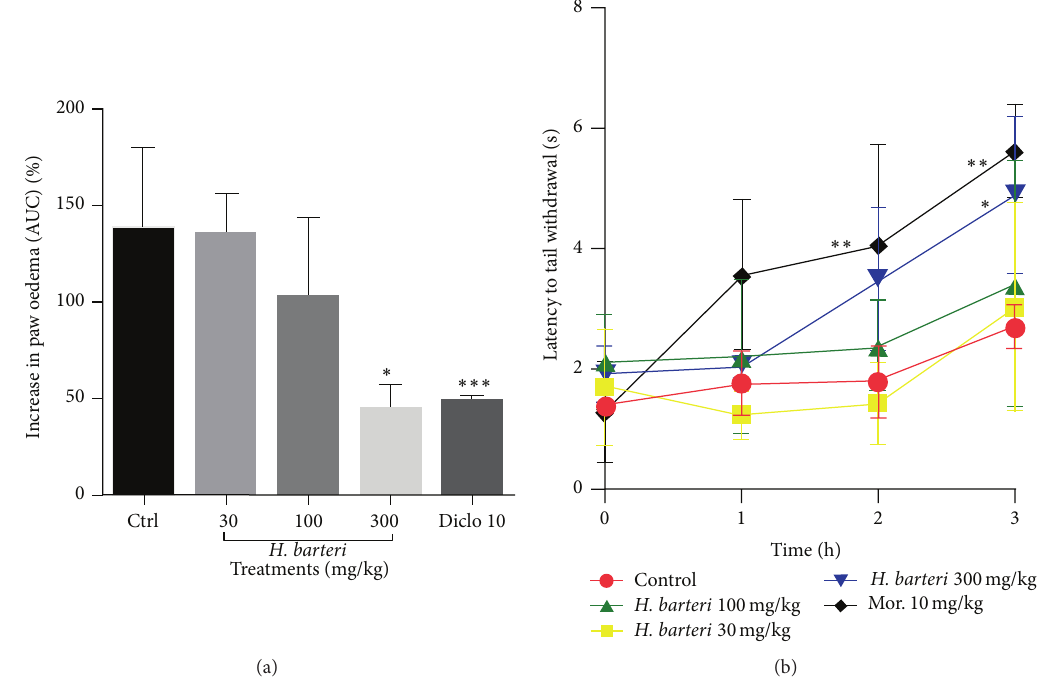
Figure 5: The effect of H. barteri root extract on (a) carrageenan-induced inflammation (AUC) and (b) tail withdrawal in the thermal nociception test (time course curve). Data are presented as mean ± SEM. ∗∗∗ 𝑃 < 0.001 and ∗ 𝑃 < 0.05 compared to vehicle-treated group (one-way analysis of variance followed by Tukey’s post hoc